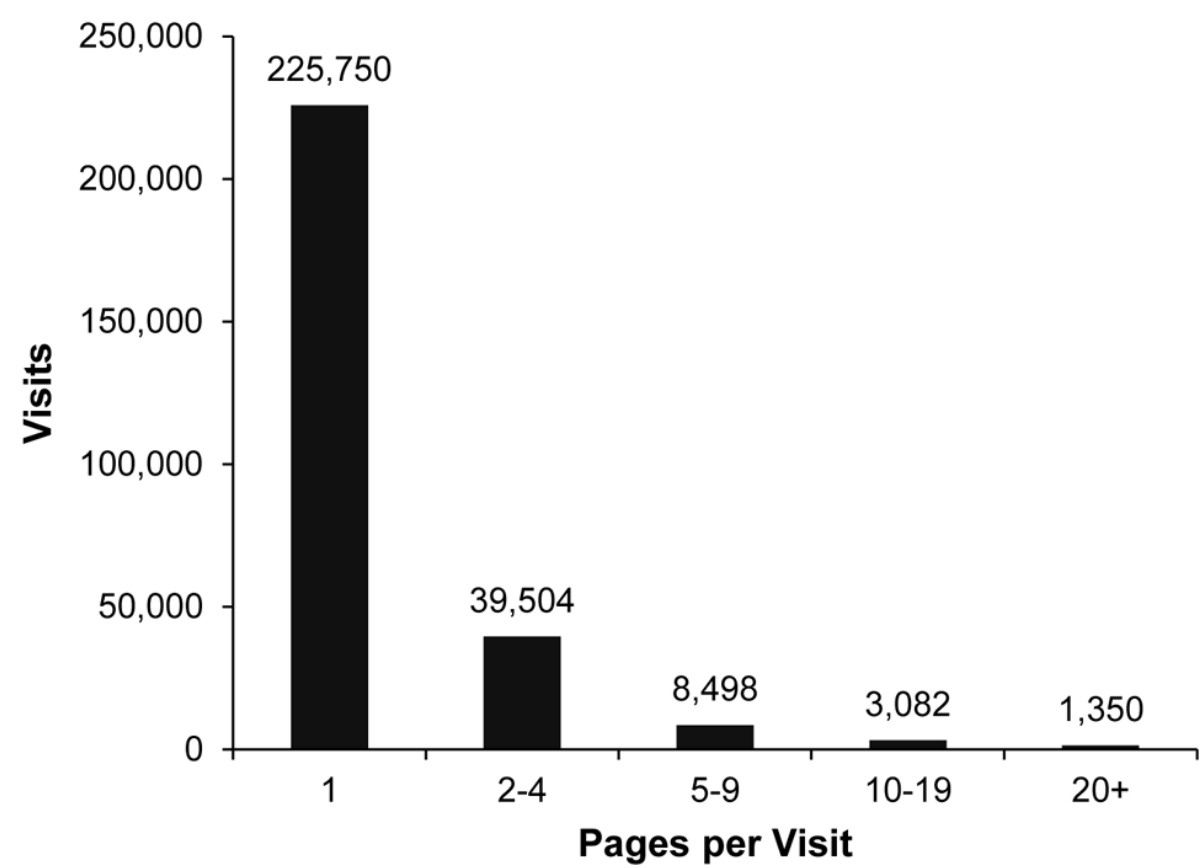
Figure 4. Distribution of visitors by depth of visit (pages/visit) during Months 23-28 from